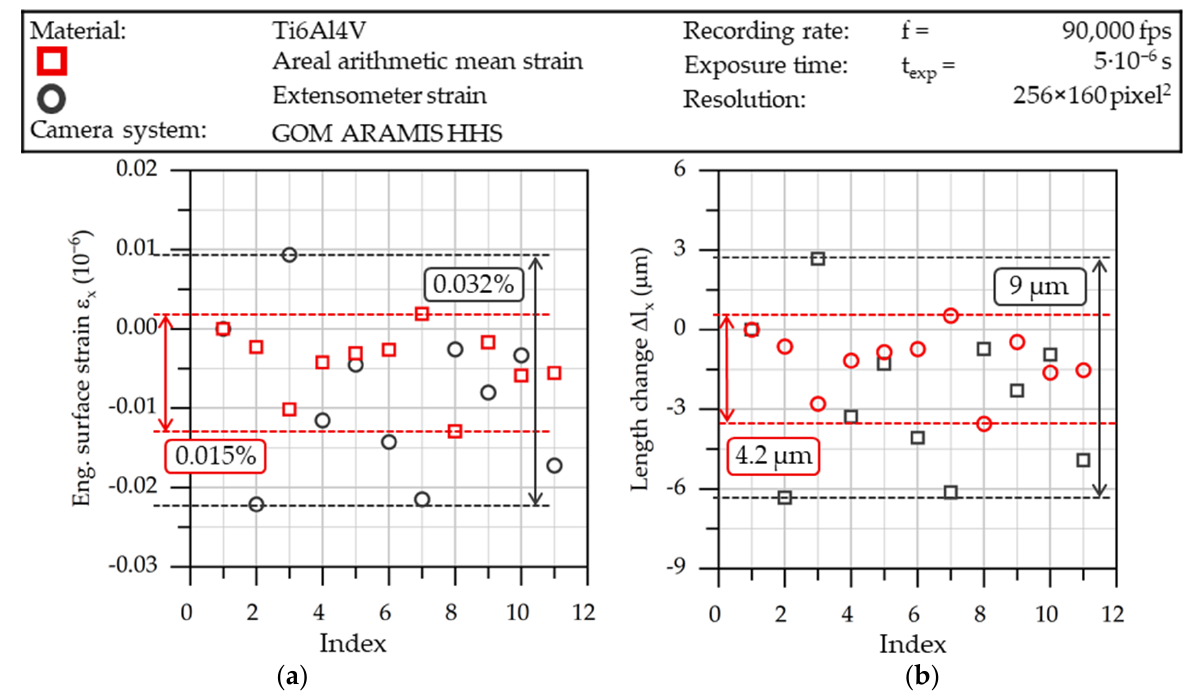
Figure 7. Maximum deviation in ( a ) strain and ( b ) length change.